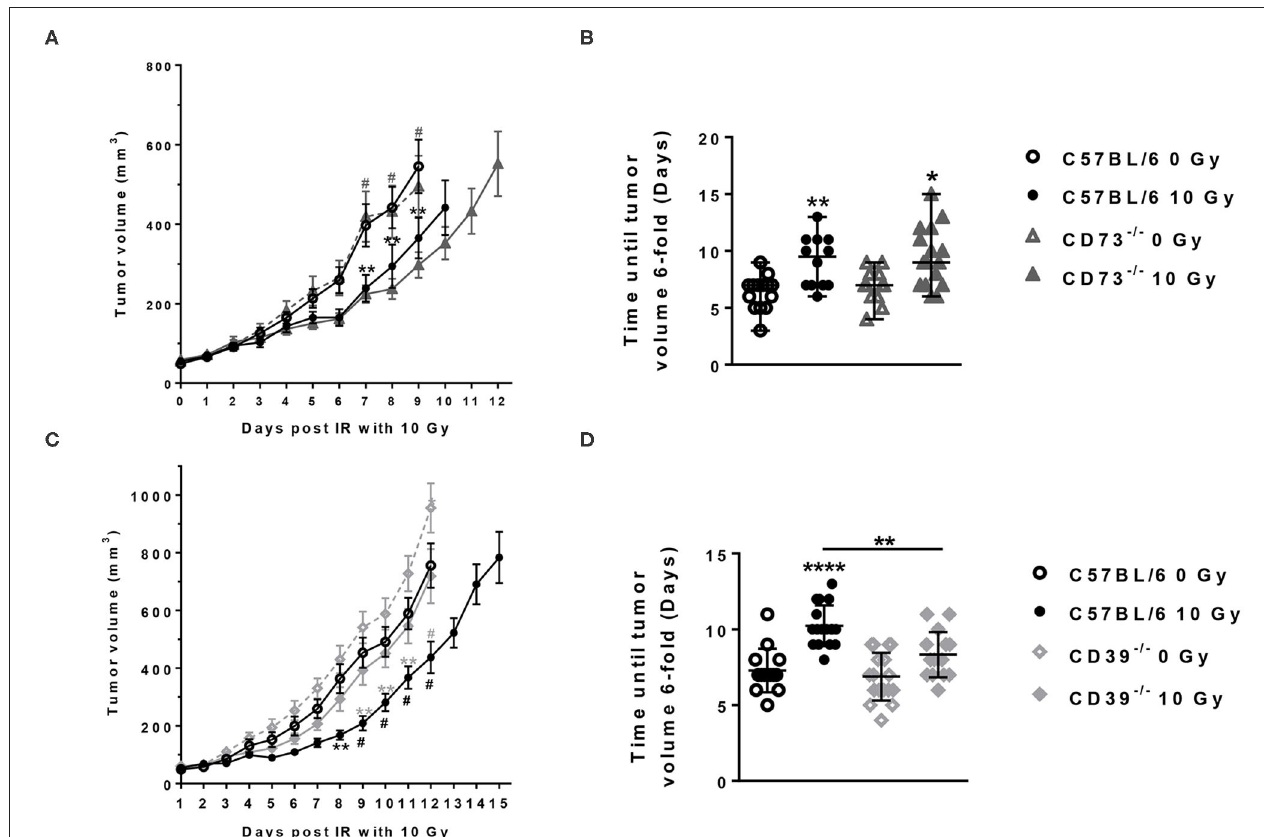
FIGURE 2 | Host CD39 deficiency accelerates LLC1 tumor growth and reduces radiation-induced tumor growth delay. LLC1 tumor cells (0.5 × 10 6 cells each) were subcutaneously transplanted onto the hindlimb of C57BL/6 wild-type (circles) CD73-knockout [knockout ( − / − ), triangles] and CD39 − / − (diamonds) mice. Hind-leg single-dose irradiation with 0 or 10Gy was conducted at the timepoint of tumor manifestation ( ∼ 100 mm 3 ). LLC1 tumor volume in mm 3 in respective experimental groups was determined at indicated time points using a sliding caliper (A/C). Growth delay was calculated as time (days) until the 6-fold tumor volume was reached (B/D). Shown are means ± SEM, * P ≤ 0.05, ** P ≤ 0.01, # , **** P ≤ 0.0001 analyzed by two-way ANOVA followed by a post hoc Tukey test, n (A) = 15/17/17/15; n (B) = 17/15/13/16; n (C) = 16/14/13/16, n (D) = 13/14/15/15. In (A,C) , significant results between the animal of the same groups are marked with asterisks (0